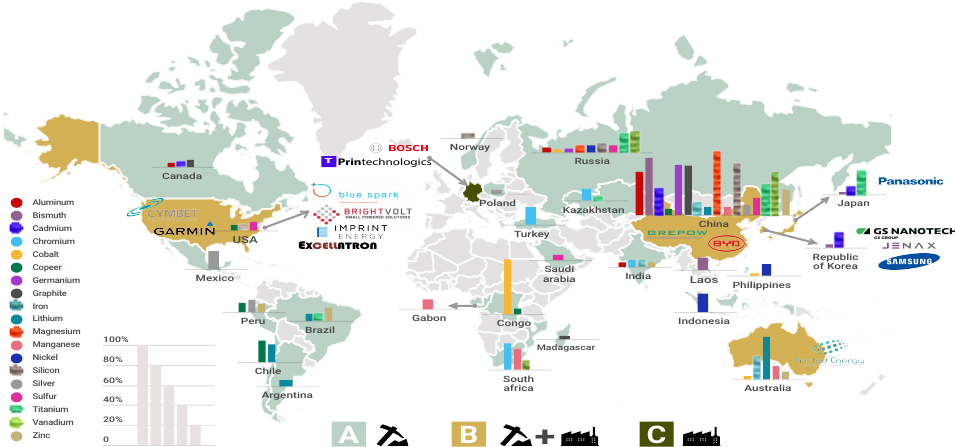
Figure 5. Geographical distribution of mineral resources vs. battery manufacturing companies. (A) Countries with mineral resources, (B) countries with mineral resources and manufacturing companies, and (C) manufacturing countries. Note: the length of the bar indicates the relative fraction of the total production. Graph constructed by the authors. Data from US Geological Survey, Mineral Commodity Summaries